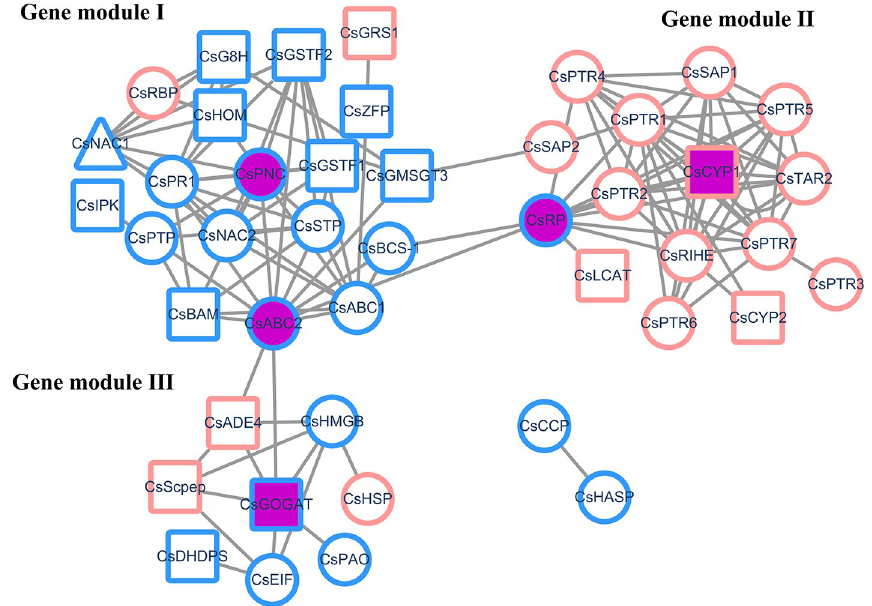
Fig 2. A modeled gene network associated with thea biosynthesis. In the network, square, triangle, and circle nodes denoted enzymes genes, TF genes and other types of functional genes, respectively. An edge was placed between two genes indicating they had gene co-expression or protein-protein interactions. The outlined red and blue of a node denoted upregulated and downregulated expression pattern of a certain gene, respectively. Solid purple of a node denoted the five representative hub genes. Module I- III were labeled in the upper-left or upper-right corner of the corresponding gene functional modules.